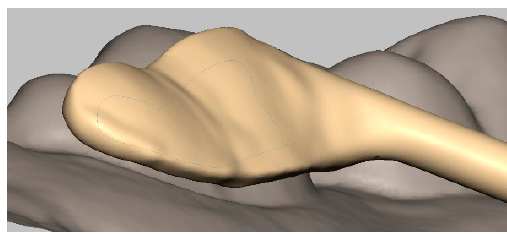
Figure 2. An adhesive plate on the